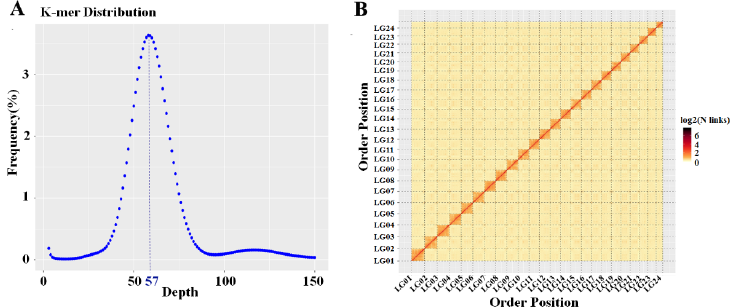
Figure 1. Genome survey and genome-wide Hi-C heatmap of S. chuatsi . ( A ) K-mer distribution map of S. chuatsi with K = 19; the K-mer depth corresponding to the main peak was 57. ( B ) A genome- wide Hi-C heatmap of S. chuatsi ; LG 1–24 refer to chromosomes